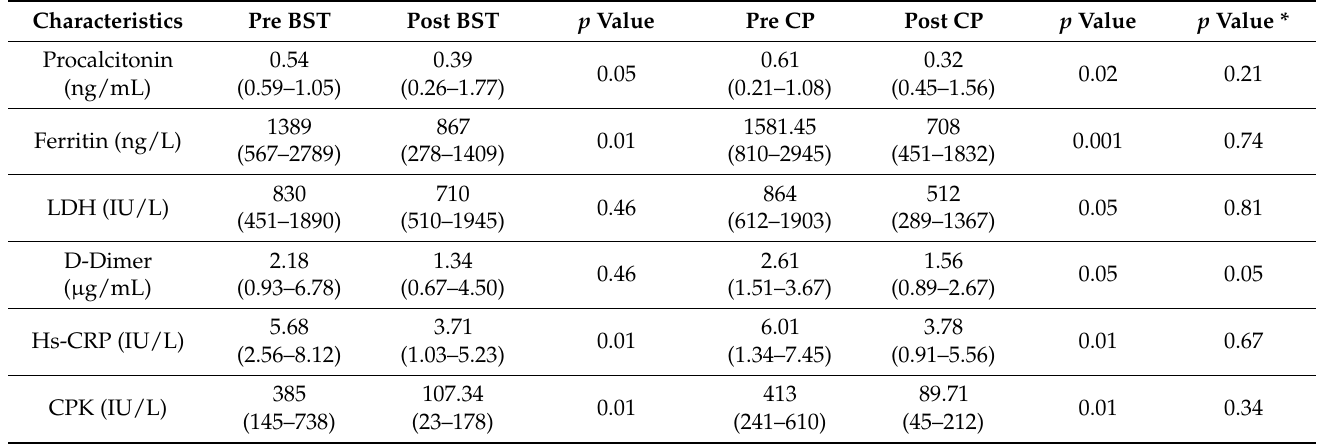
Table 4. Comparison of “risk factors identified” in best standard treatment arm and convalescent plasma